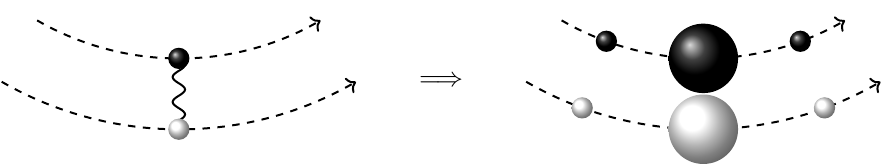
Figure 3 . (Left) Open string stretching between two D3-branes as a probe. (Right) D3-branes start expanding and